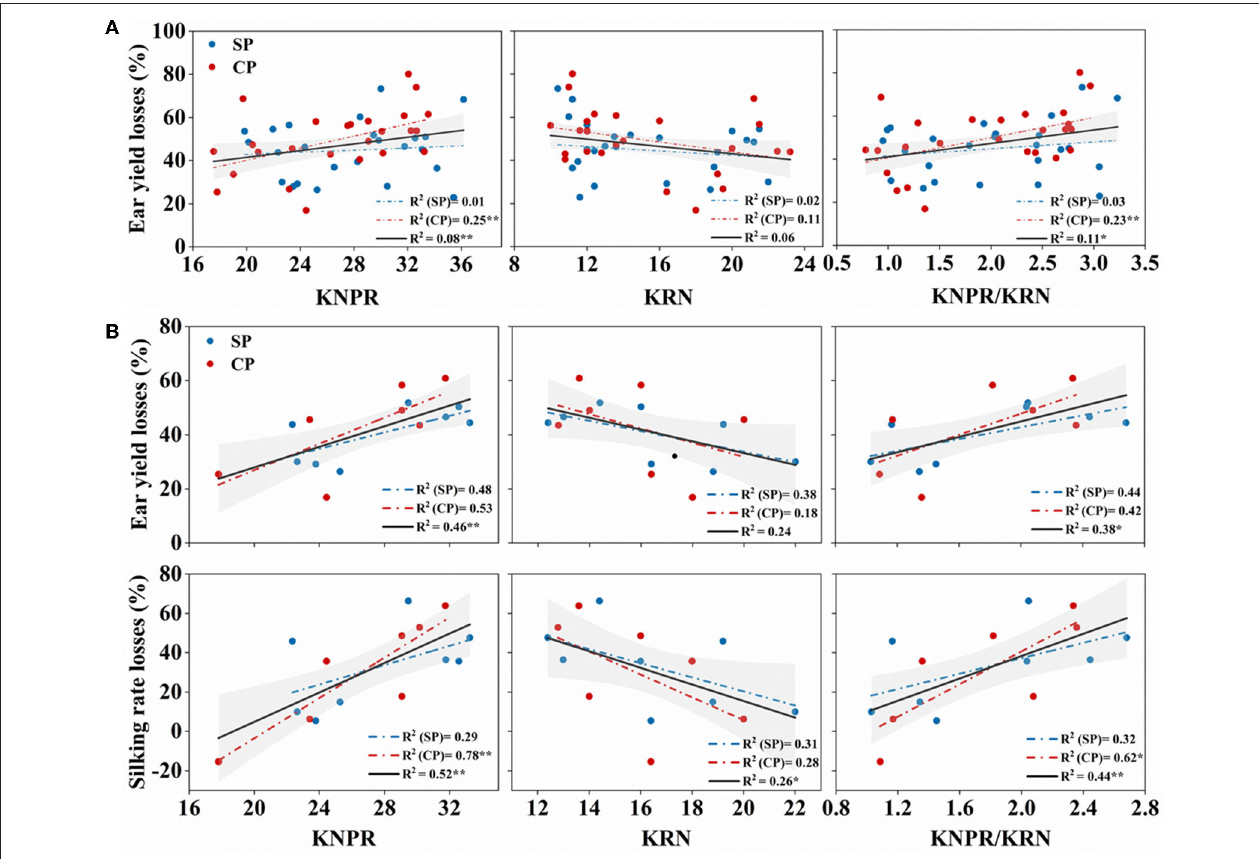
FIGURE 8 | (A) Correlation between ear traits and ear yield losses in 27 hybrids; (B) correlation between ear traits and ear yield losses and silking rate losses in the eight hybrids with similar sink capacity. The red dot represents synchronous pollination (SP) treatments, and the blue dot represents continued pollination (CP) treatments. The gray strip represents confidence intervals of 95%. * and ** indicate significant differences at 0.05 and 0.01 levels, respectively. KNPR, kernel number per row; KRN, kernel row